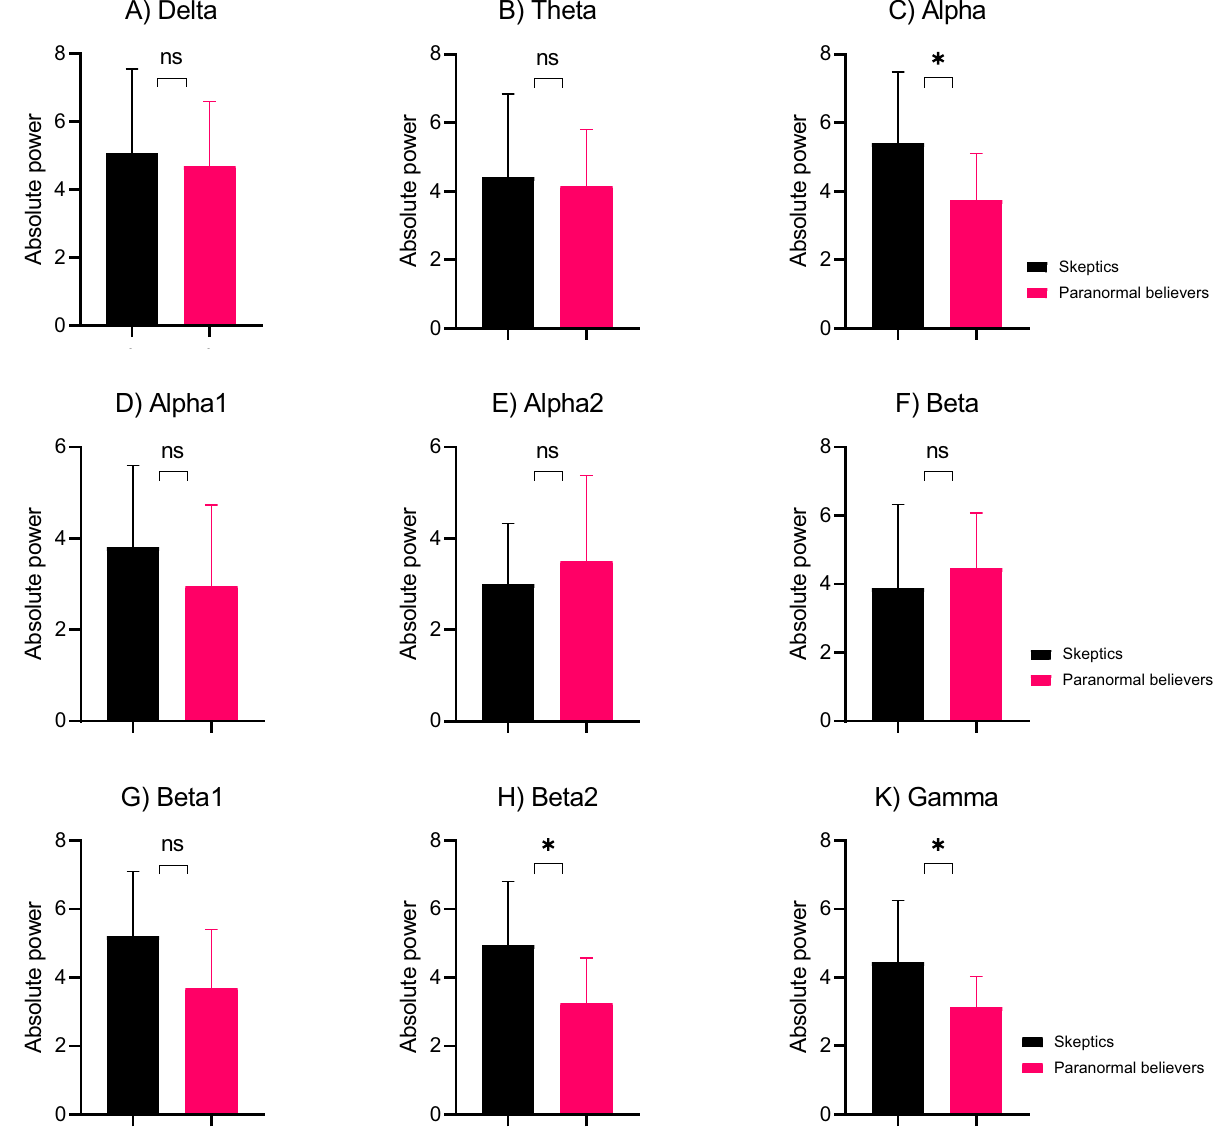
Figure 4. The absolute power of EEG frequency bands in the paranormal believers and skeptics groups in frontal lobe. The figures show the absolute power of the bands of ( A ) delta, ( B ) theta, ( C ) alpha, ( D ) alpha1, ( E ) alpha2, ( F ) beta, ( G ) beta1, ( H ) beta2, and ( K ) gamma. The error bars are SD. The black bar charts and red bar charts are for the skeptics and paranormal believers groups, respectively. *P <